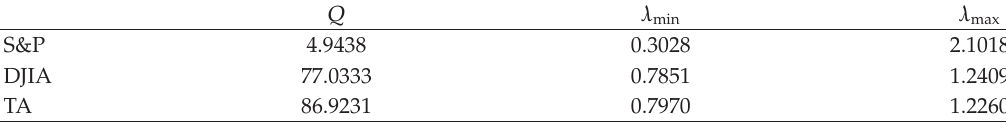
Table 1: Value of Q, λ min , and λ max for the random matrices created for the S&P, DJIA, and TA datasets. Q λ min λ max